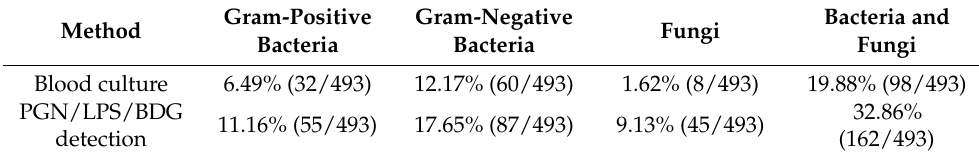
Table 4. Positive rates of the blood culture and the multi-marker approach detection.